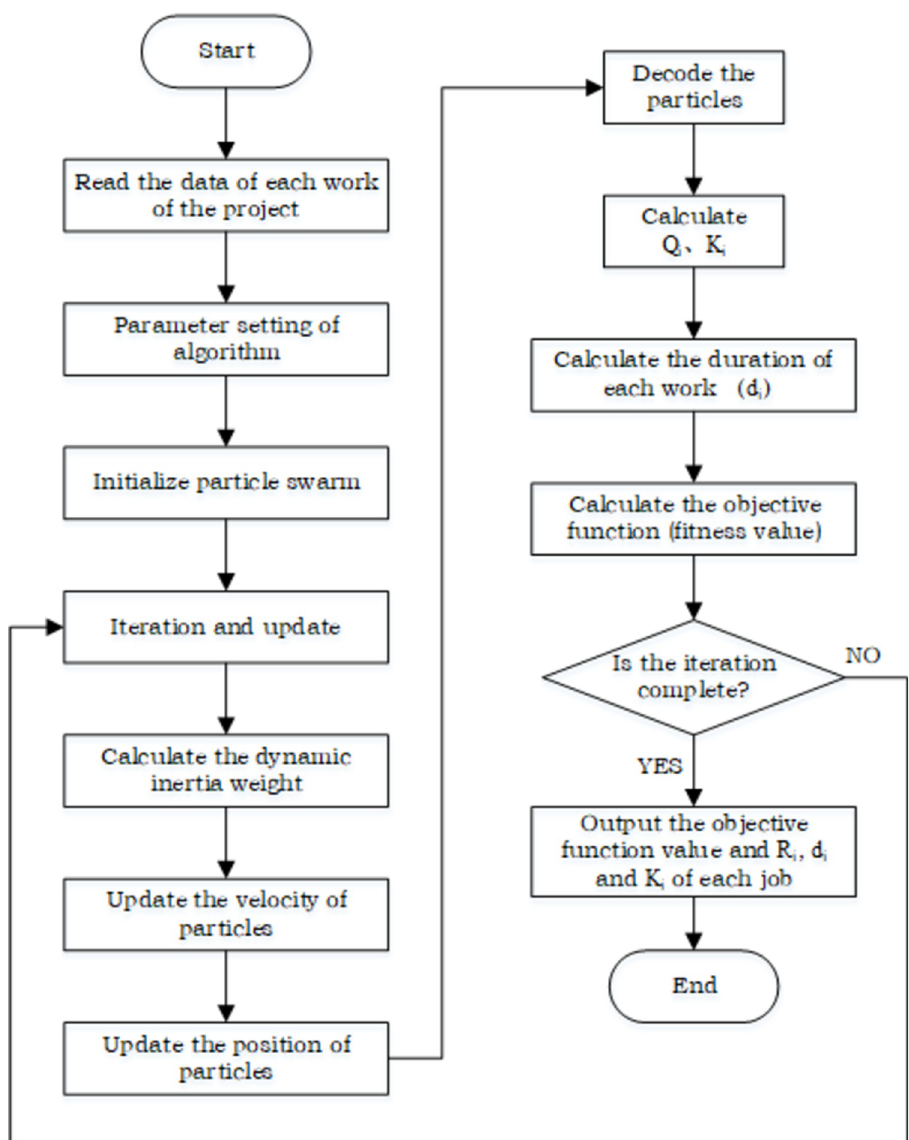
Fig 2. Improved PSO solution